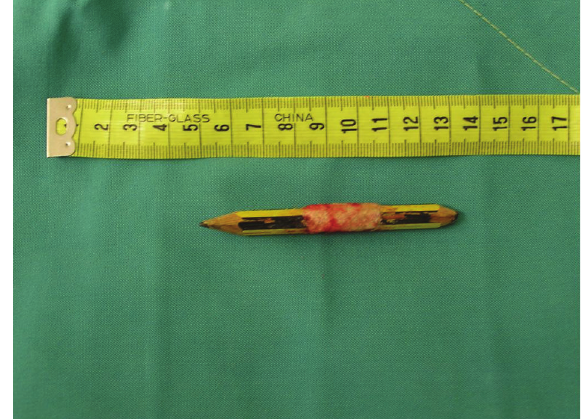
Figure 2: Ultrasonography shows a straight echogenic foreign body (arrow).